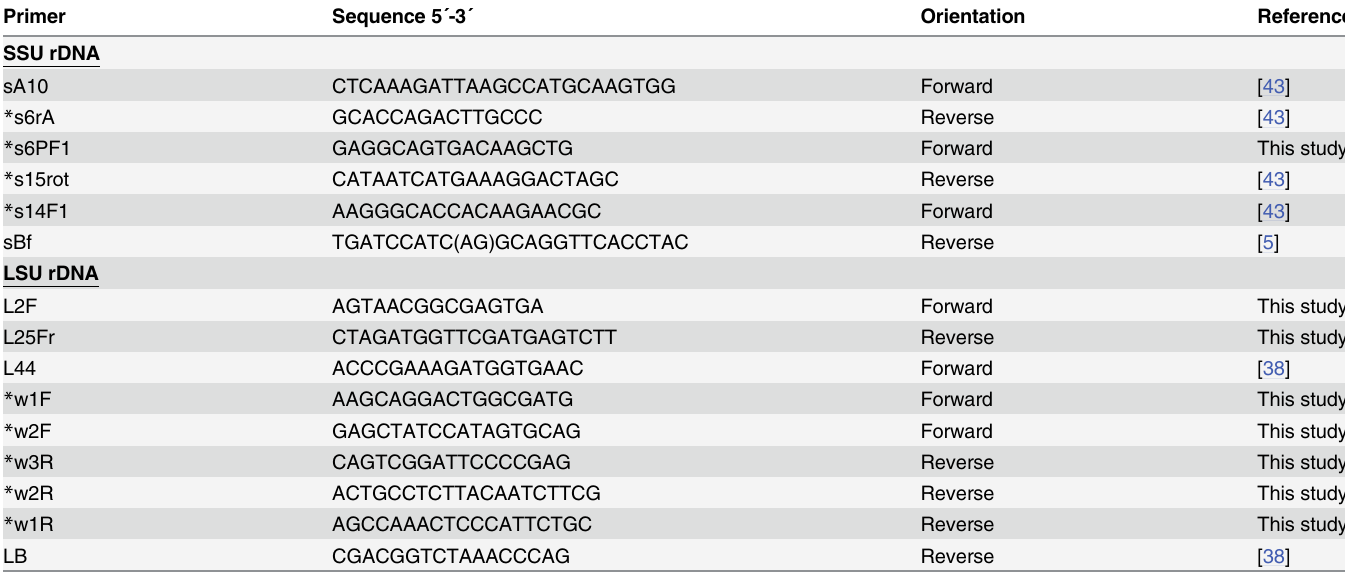
Table 1. Primers used for the PCR amplification and sequencing.